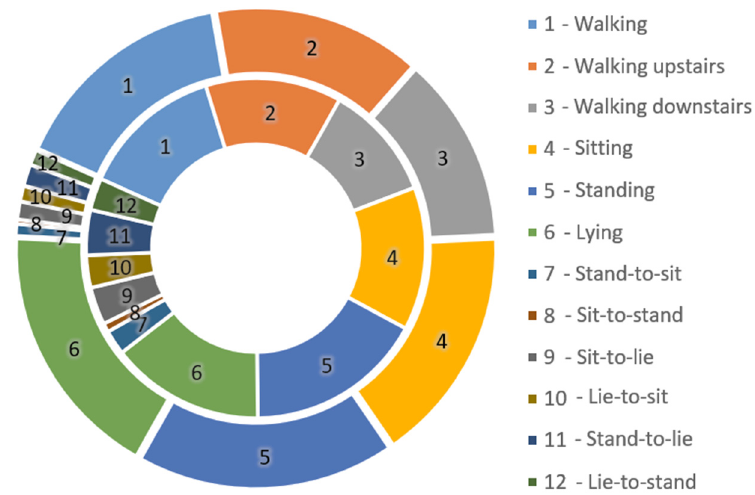
Figure 1. Class distributions of the whole preprocessed UCI-HAPT dataset (outer circle) and its subset (inner circle).